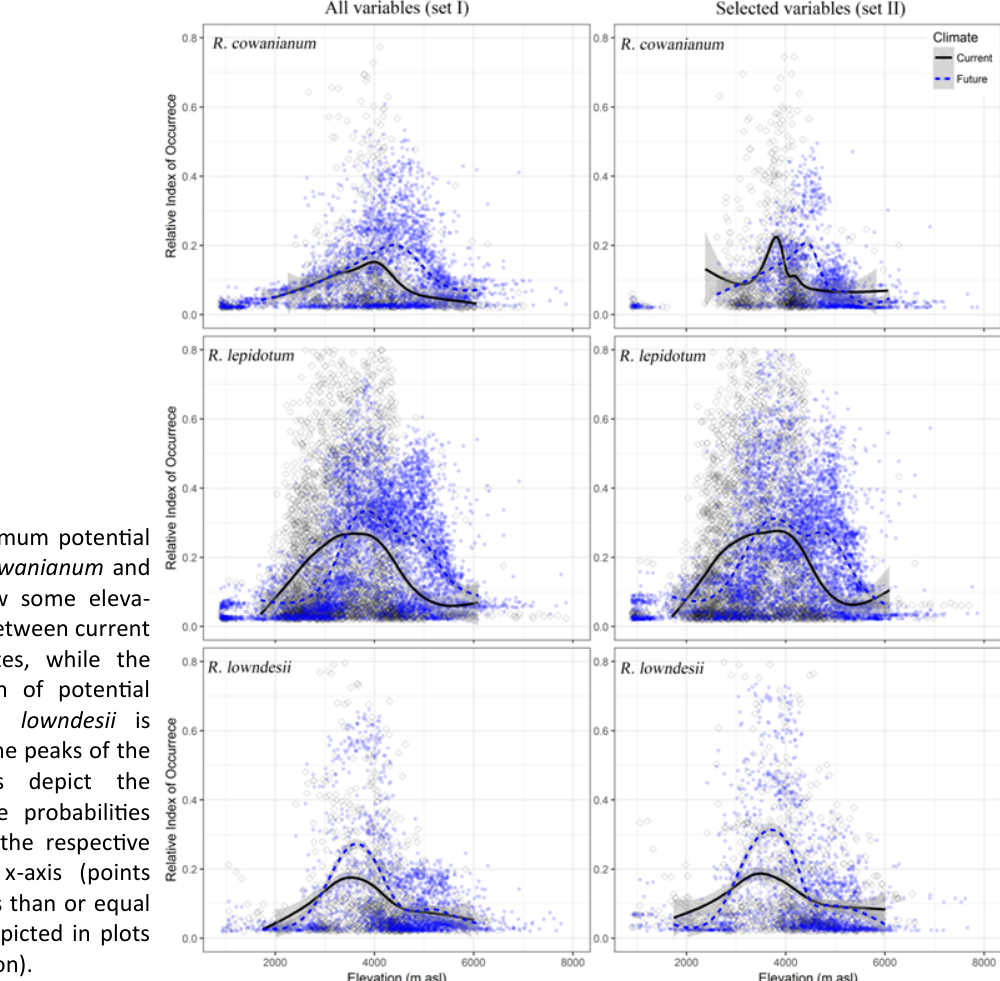
Figure 5. The optimum potential elevation for R. cowanianum and R. lepidotum show some eleva- tional difference between current and future climates, while the optimum elevation of potential distribution of R. lowndesii is about the same. The peaks of the smoothing curves depict the highest occurrence probabilities of the species in the respective elevation in the x - axis (points with RIO value less than or equal to 0.02 are not depicted in plots for better